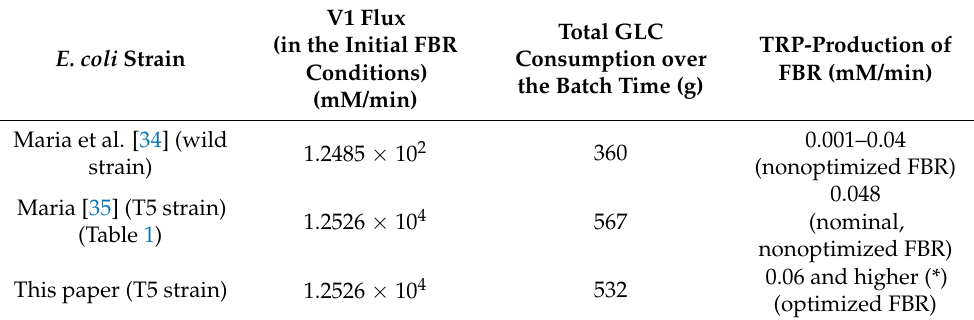
Table 5. Efficiency of the modified E. coli T5 strain for GLC uptake and for the TRP production in the tested FBR of (Table